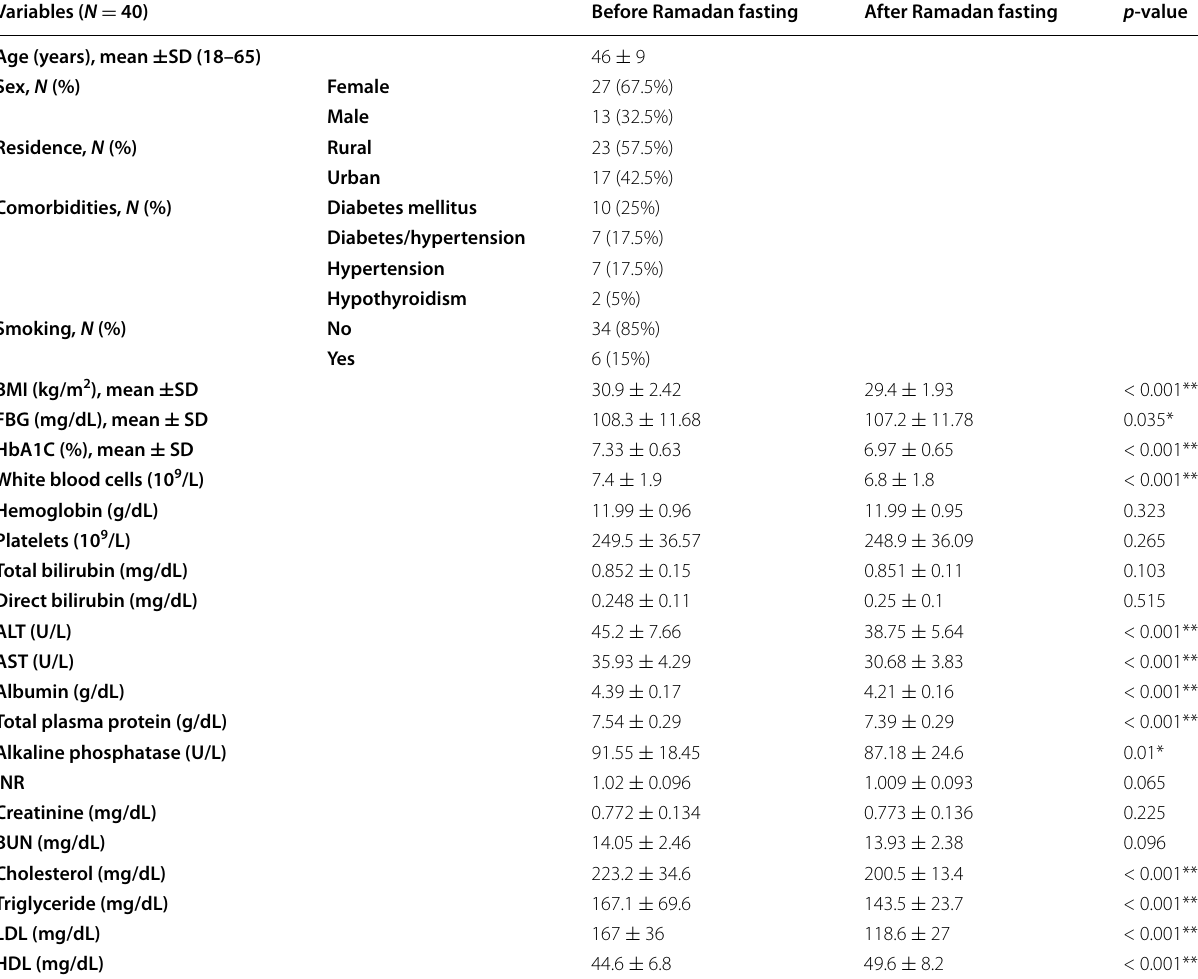
Table 1 Anthropometric and biochemical parameters of the study group before and after Ramadan fasting